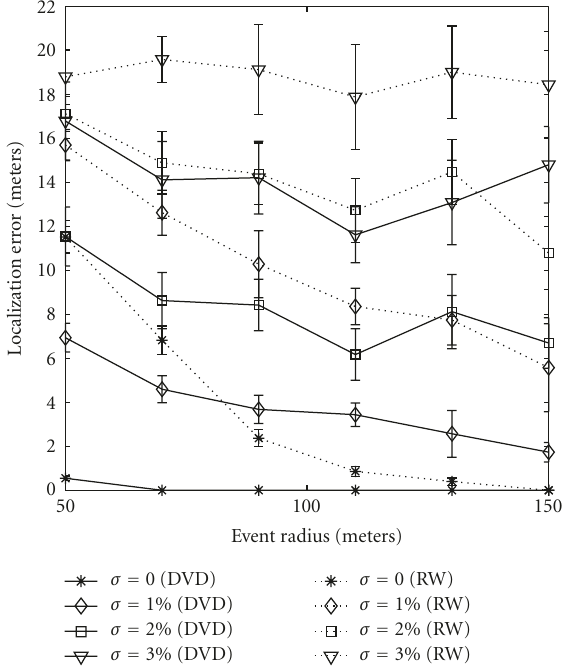
Figure 20: Sensitivity of Packet loss for DVD and